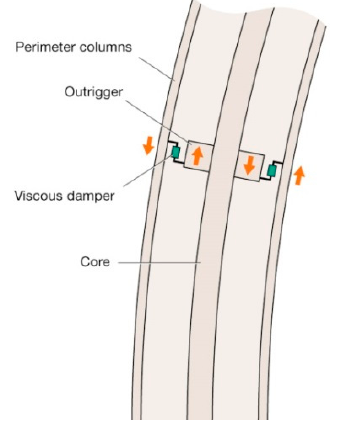
Figure 6. Damped outrigger (© Arup).